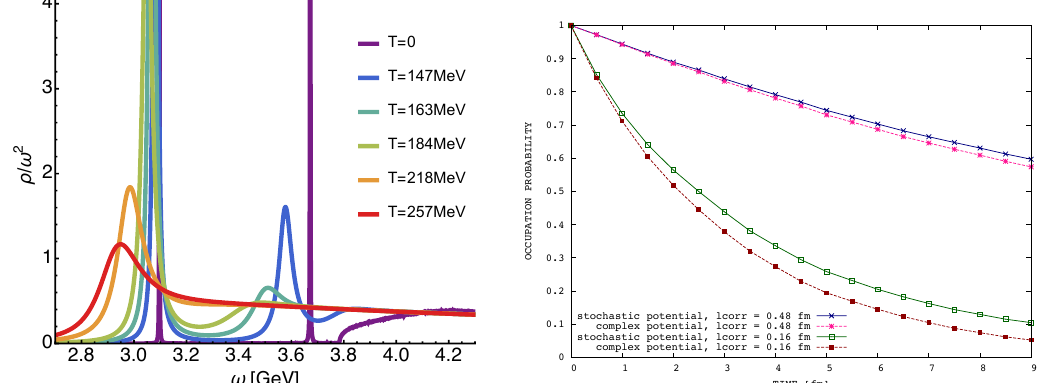
Figure 2. ( left ) Charmonium in-medium spectral functions from the continuum corrected in-medium heavy quark potential [25]. ( right ) Survival probabilities of the ground state in a one-dimensional model calculation of the real-time dynamics of bottomonium in the open-quantum systems approach [27]. The blue and green curve correspond to the stochastic potential computation with different correlation lengths. The pink and dark red curves arise from a naive Schrödinger equation with complex